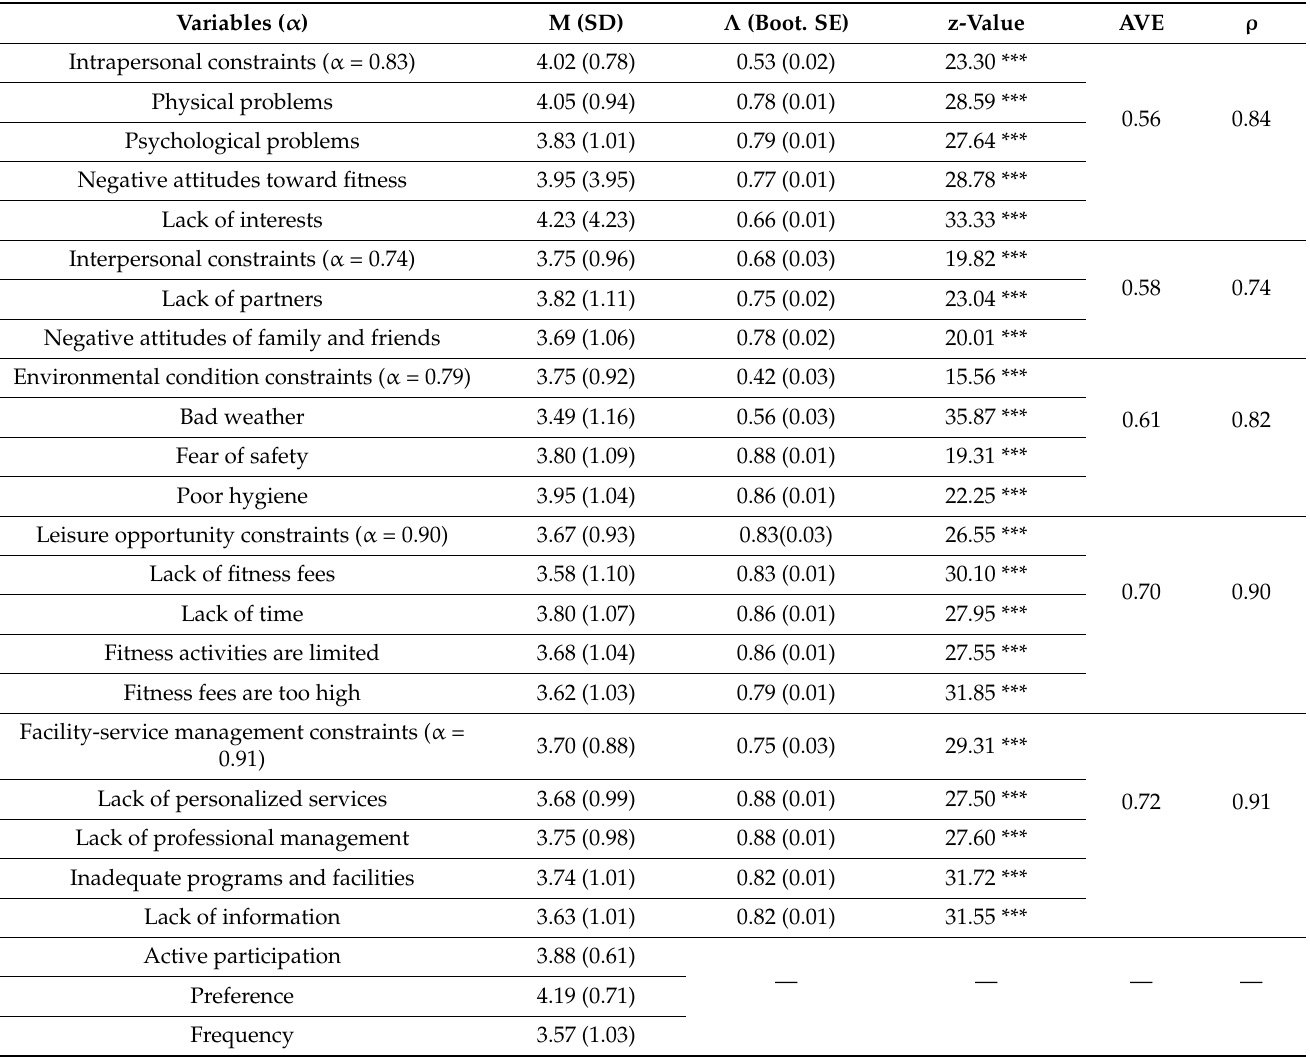
Table 3. Results of the confirmatory factor analysis.